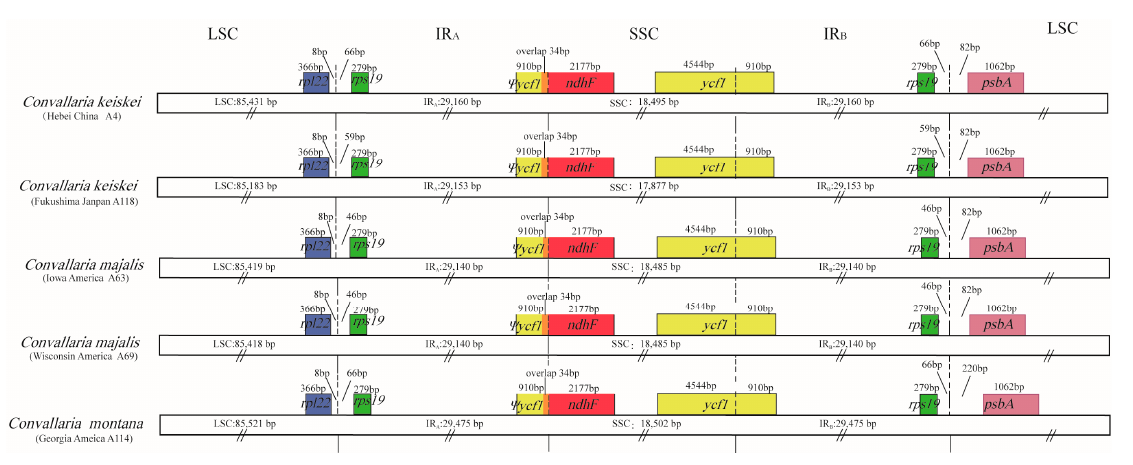
Figure 2. Comparison of LSC, IRs, and SSC junctions among Convallaria plastomes.